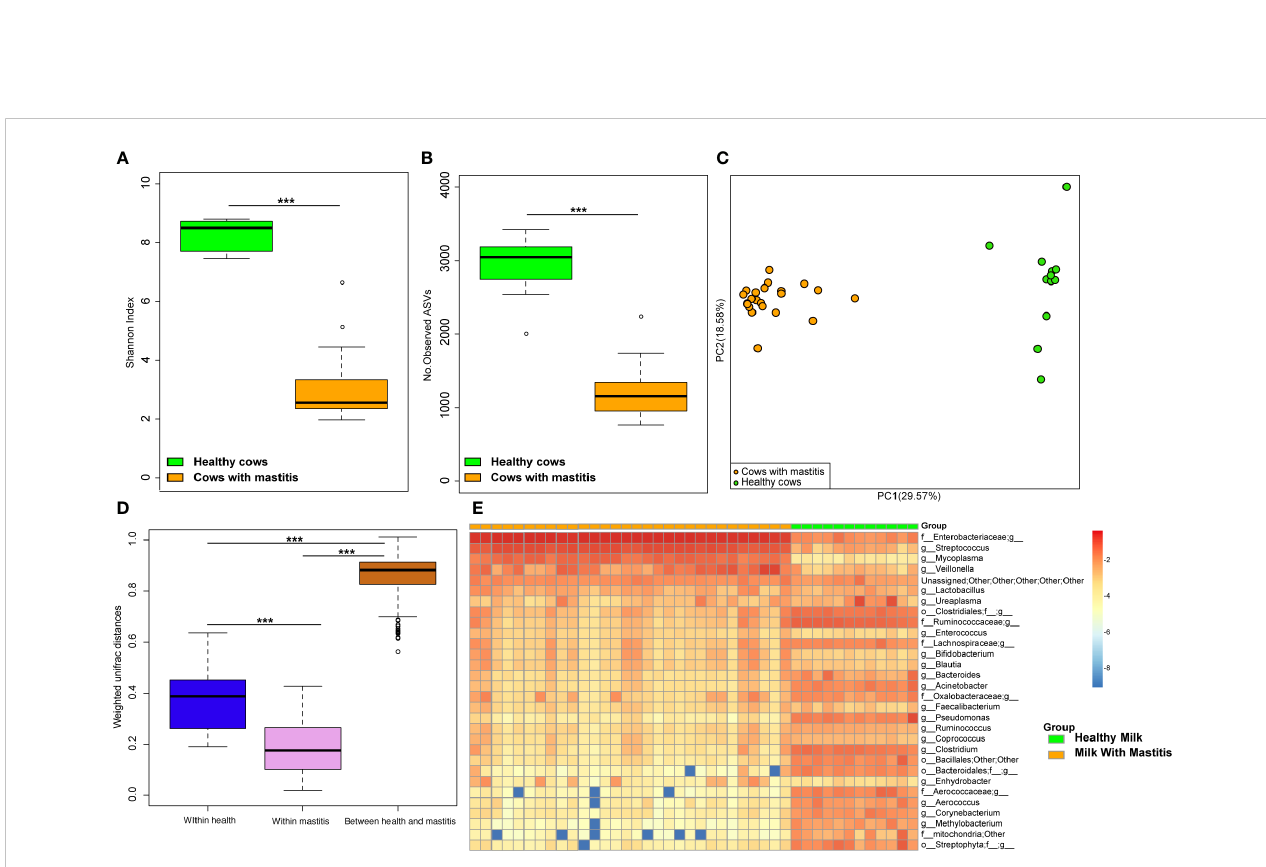
FIGURE 5 Comparison of the composition of milk bacteria between dairy cows with mastitis and healthy cows. (A) Shannon index and (B) Number of observed ASVs of milk microbiotas in dairy cows with mastitis and healthy cows; (C) Principal coordinate analysis (PCoA) based on Weighted Unifrac distance of milk microbiotas in dairy cows with mastitis and healthy cows; (D) Interindividual variations were determined by average weighted UniFrac distances between individuals in milk microbiotas of dairy cows with mastitis and healthy cows, respectively, while between-group variations were determined by distances between cows with mastitis and healthy cows. (E) Heatmap of top 30 most abundance genera in milk of cows with mastitis and healthy cows. ( ∗∗∗ means p < 0.001; p values calculated by Mann – Whitney U in (A, B) p values calculated by the One-way ANOVA test followed by post-hoc Dunn ’ s multiple comparisons test in (D) .